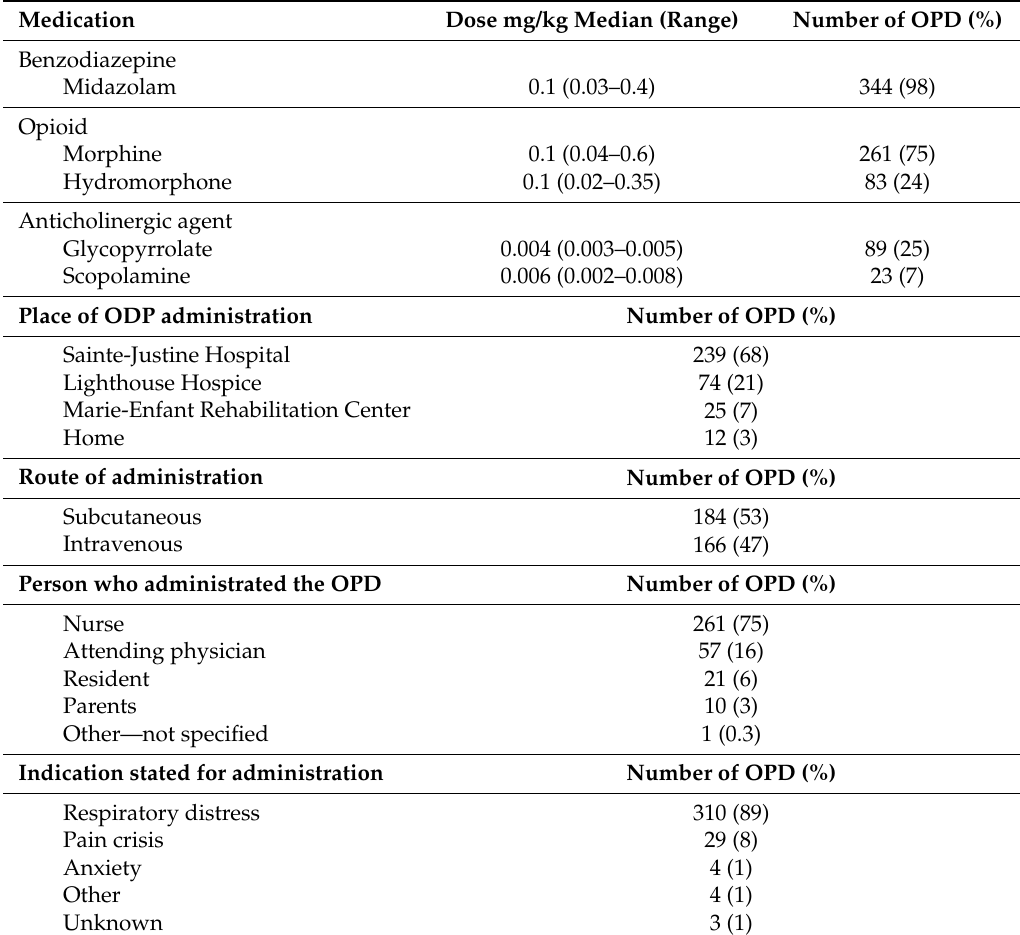
Table 3. Characteristics of the OPD administered ( n =